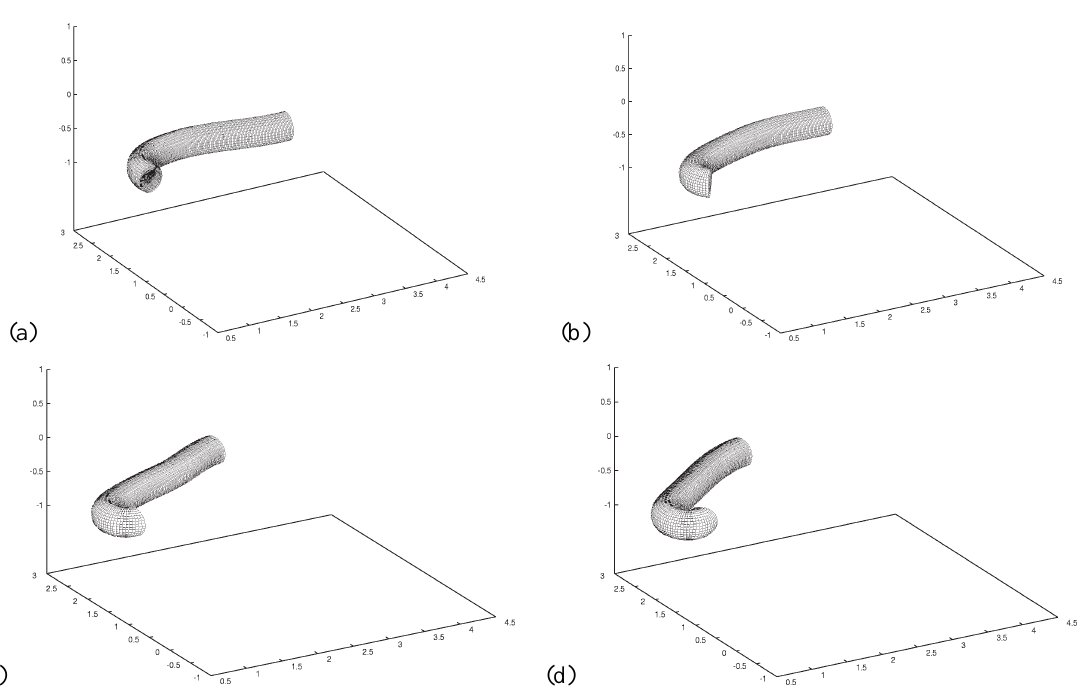
Fig. 6. Motion of flexible pipe for (cid:28) = 0 : 0 (cid:24) 0 : 15 s: (a) (cid:28) = 0 : 07 s; (b) (cid:28) = 0 : 10 s; (c) (cid:28) = 0 : 12 s; (d) (cid:28) = 0 : 15 s.